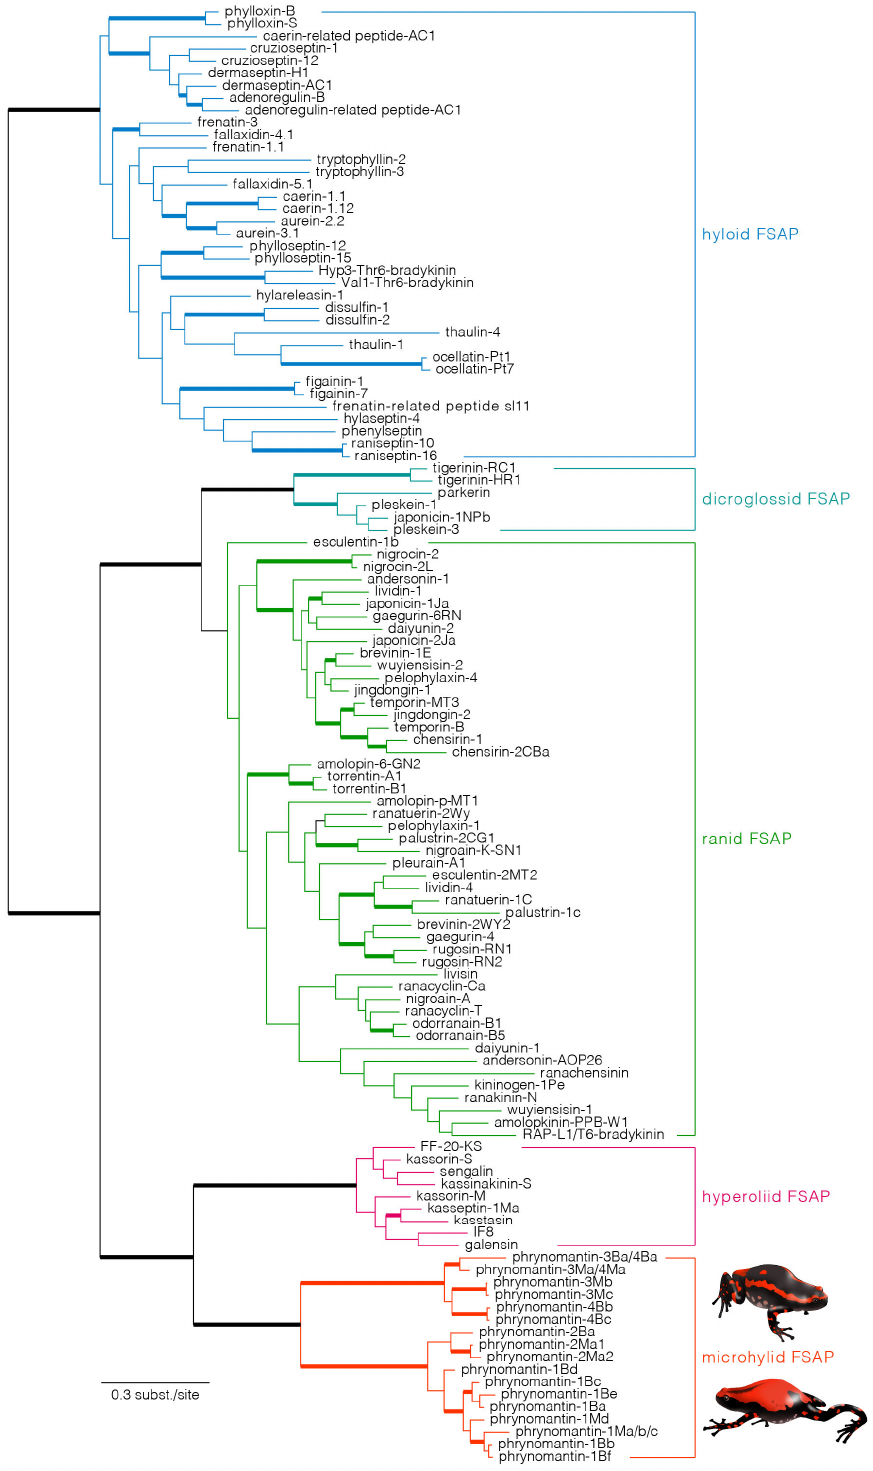
Figure 4. The evolutionary diversification of frog skin active peptide (FSAP) genes in Neobatrachia (advanced frogs). The depicted tree is a Bayesian consensus phylogram based on two parallel Markov chain Monte Carlo runs of 20 million generations each, using a GTR + G + I model of nucleotide substitution. Branches with posterior probabilities ≥ 0.95 are drawn as thick lines. Each clade comprising all FSAP representatives of a single frog family is highlighted in a di ff erent colour; the clade composed of phrynomantins is highlighted in